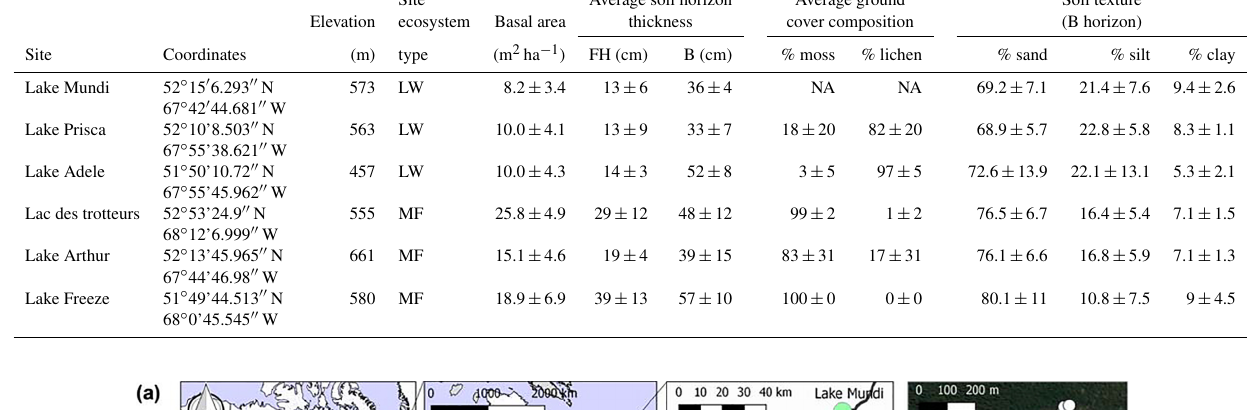
Table 1. General information and description of the six sites of study. LW is lichen woodland, and MF is moss forest. Values of basal area, ground cover composition and soil horizon thickness are given as means ± standard deviations to illustrate intra-site variability. Means where calculated from nine plots per site, regardless of the local ground cover type, but rather considering the regional ecosystem-type of the site they belonged to. NA means not determined during field sampling because of a fire that burned the forest in 2007. Site Average soil horizon Average ground Soil texture Elevation ecosystem Basal area